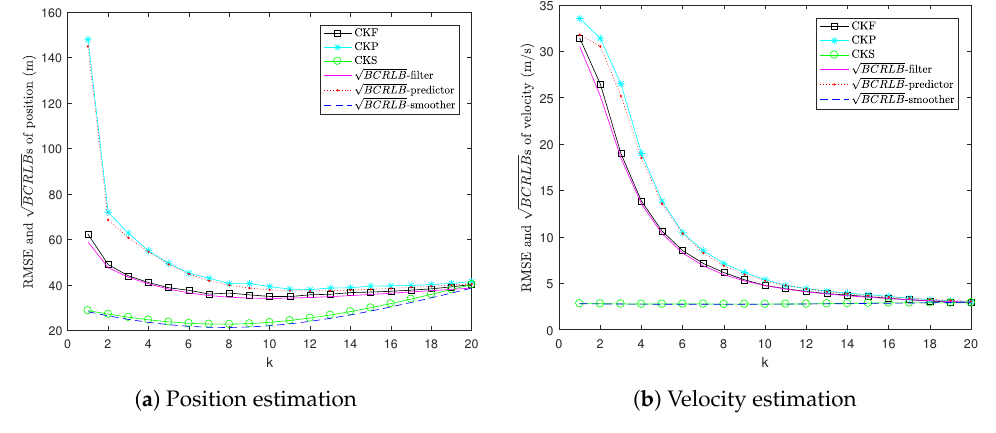
Figure 4. RMSE versus